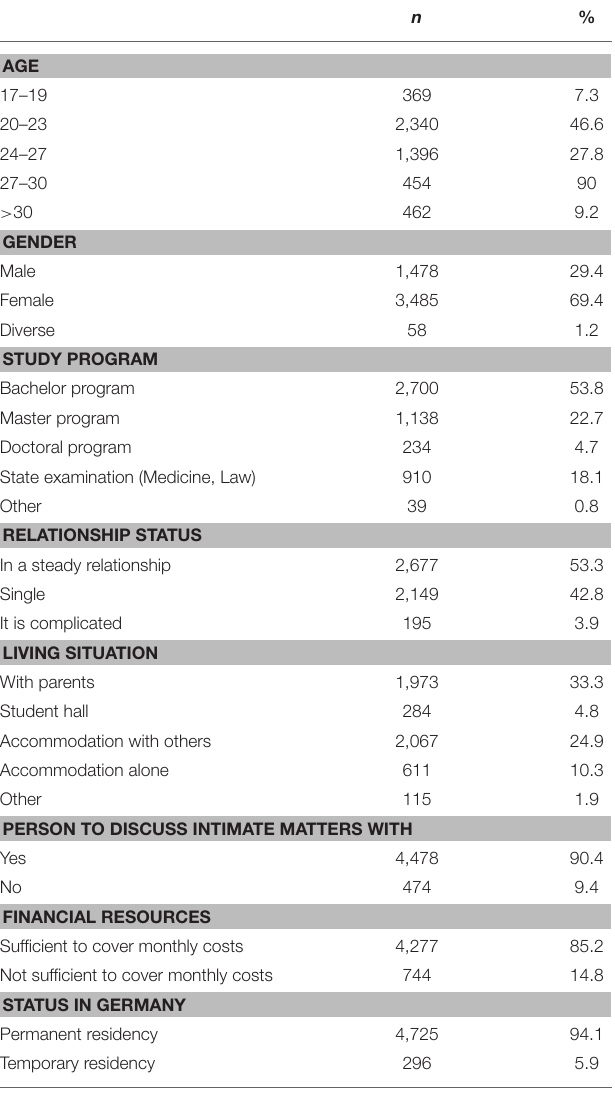
TABLE 1 | Sociodemographic and study related characteristics of